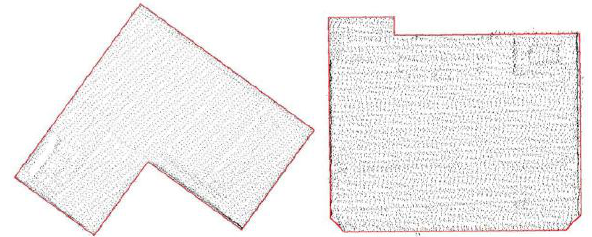
Figure 8. Building outlines after generalization.